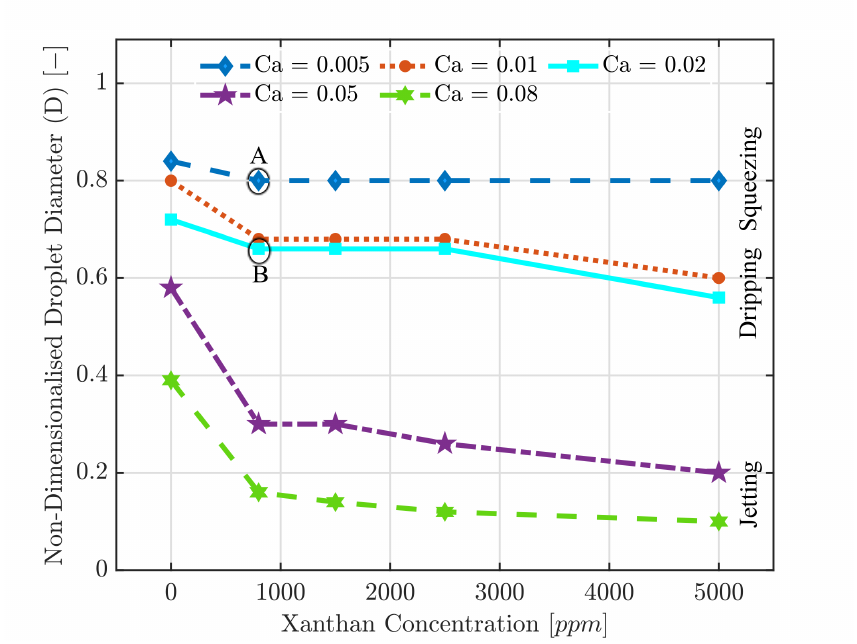
Figure 6. Non-dimensionalised droplet diameter versus xanthan concentration for different Ca . C x = 0 represents the droplet diameter for Newtonian deionised water droplets. Letters A and B indicate tests examined in more detail in Figure